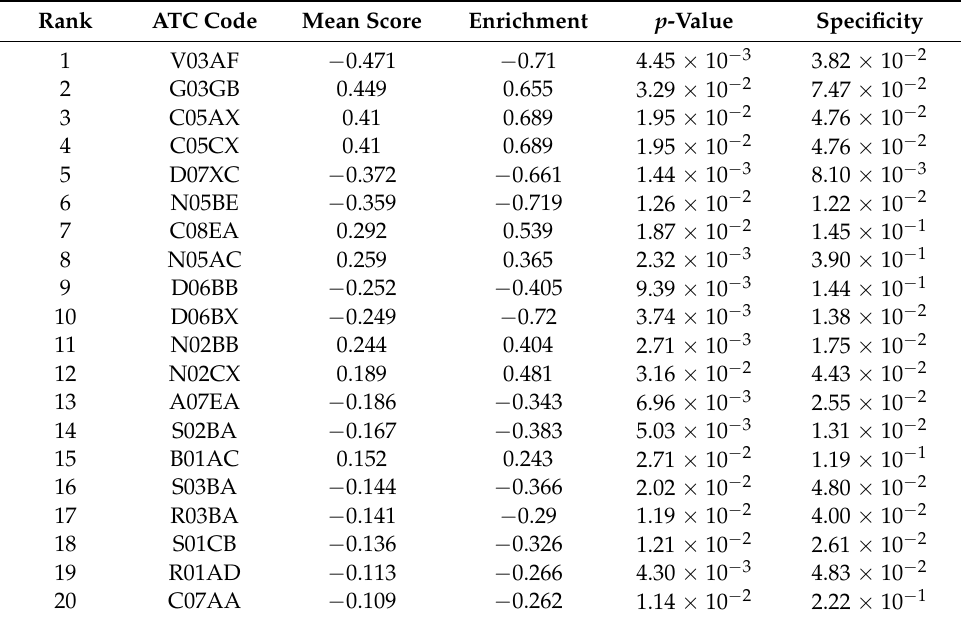
Figure 5. Chemicals-gene interaction network for the DEGs disturbed by bufadienolide-like chemicals. Square nodes represent the DEGs. Circle nodes represent the chemicals predicted by the CTD Database. The size of the nodes represents the degree. Circle nodes with red represent the similar small molecule predicted by degree (degree ≥ 30). Table 1. Top 20 CMAP2 (connectivity map, https://portals.broadinstitute.org/cmap/) hits correlated with bufadienolide-like chemicals’ treatment .